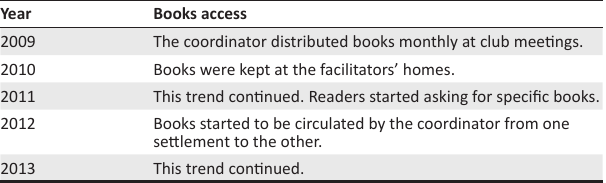
TABLE 3: Themes identified from monthly and yearly reports and field notes: Access to books.